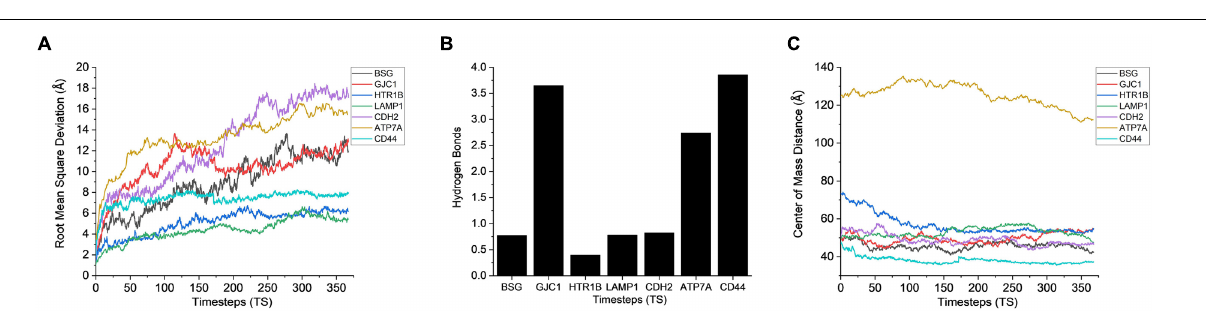
FIGURE 7 | Stability analysis for the interactions between CHO plasma membrane proteins and AMB-1 surface proteins. (A) Root mean square deviation (RMSD), (B) hydrogen bonds, and (C) center of mass (1 TS = 136